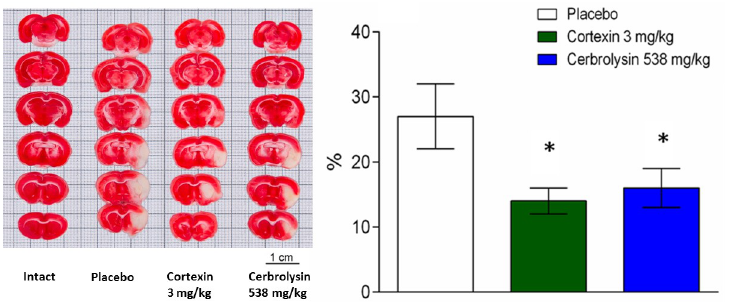
Fig 10. Representative photographs of brain slices obtained from animals with acute brain ischemia. Brain necrosis volume at 3 days (n = 9); � –p < 0.05 compared to placebo (1-way ANOVA, t-student test with Bonferroni correction); data shown as the mean ±